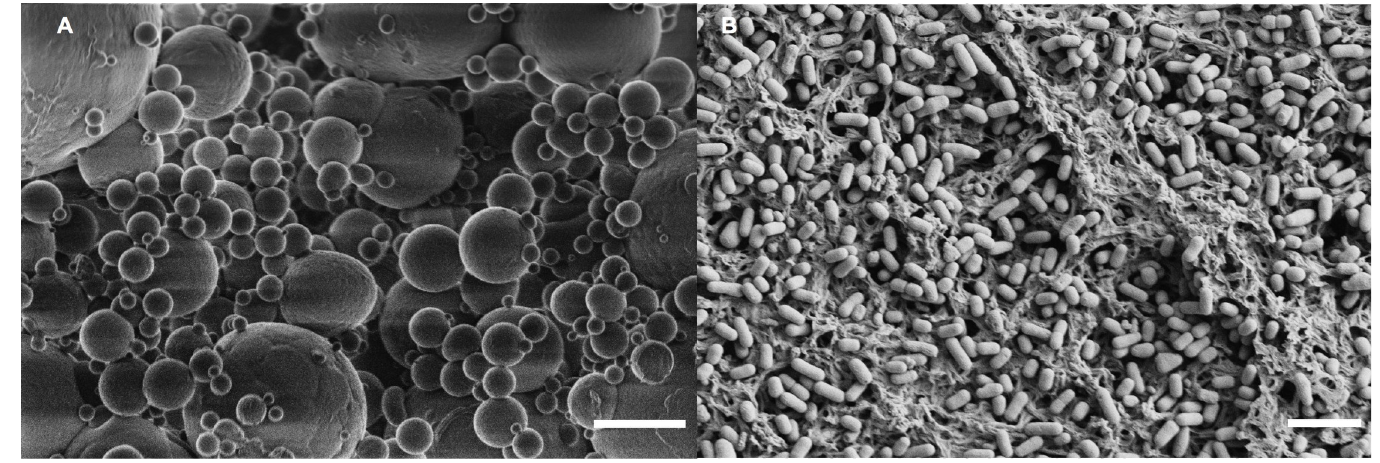
Fig 1. SEM of experimental materials. A) polyethylene nanospheres (200–9900 nm) B) Synechococcus sp . PCC 7002 Scale bars = 5 μ m.